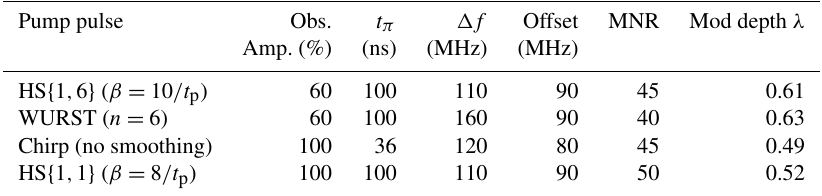
Table 3. The parameters of the observer and pump pulses that gave the best MNR for each pump pulse type. All observer pulses are Gaussian pulses with a pulse length of 74ns for a 60% intensity and 56ns for a 100% intensity. The observer frequency was 33.93GHz in all cases. The MNR was evaluated up to